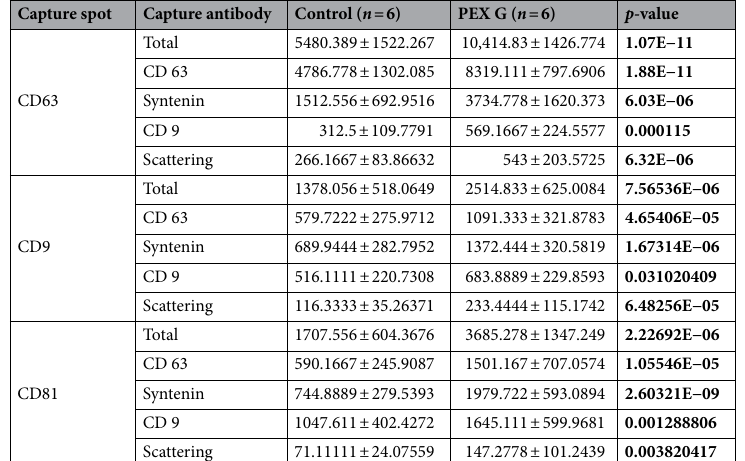
Table 2. Exosome particle count per each spot between control and PEX glaucoma patients. Bold font indicates significant p values ( p < 0.05). p -value by t-test. PEX pseudoexfoliation, G glaucoma.